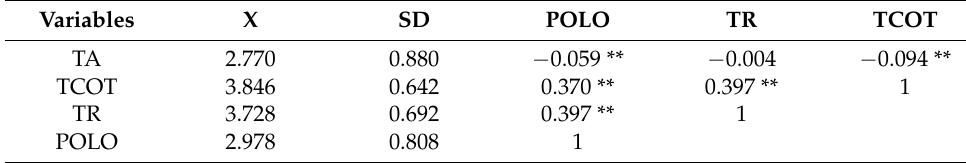
Table 1. The correlational analysis